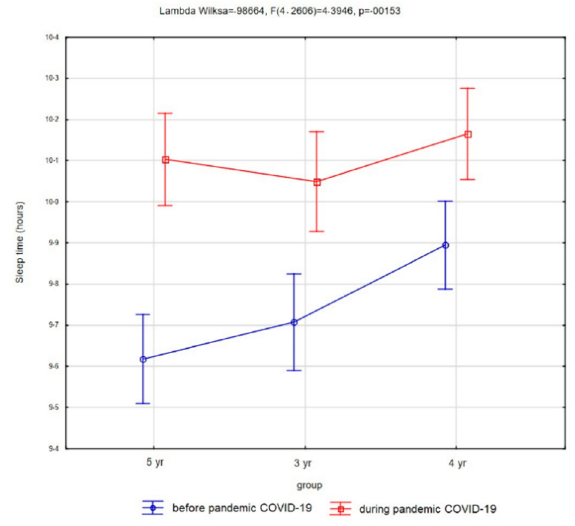
Figure 5. Average values of sleeping time in groups of children aged 3–5 years.